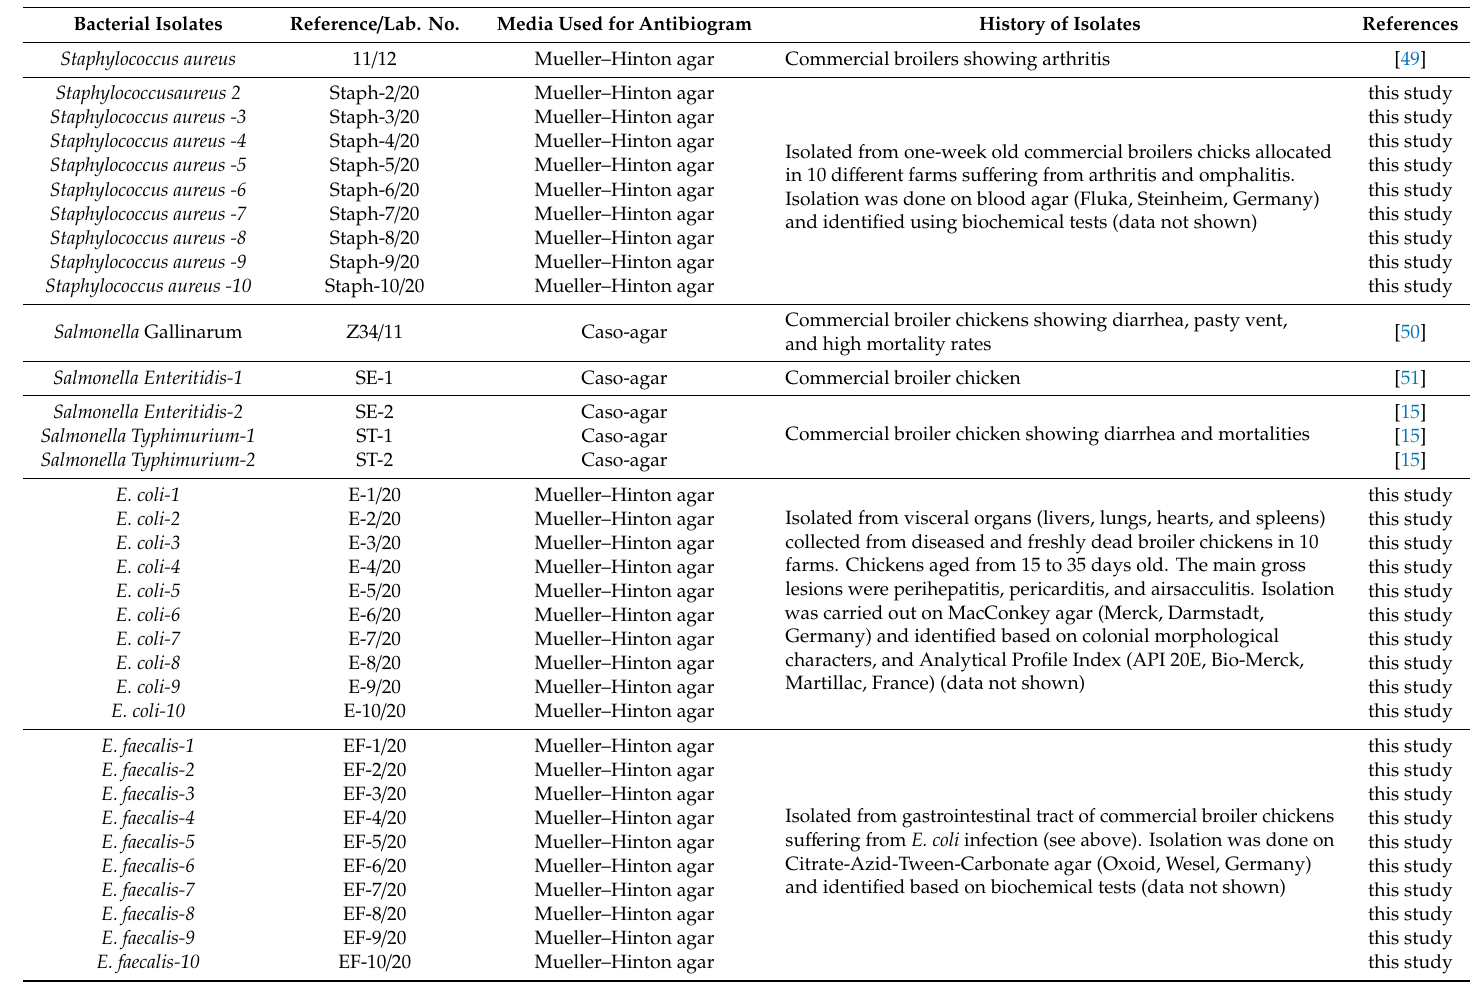
Table 1. Target strains used in this study, their origin and culture conditions. Bacterial